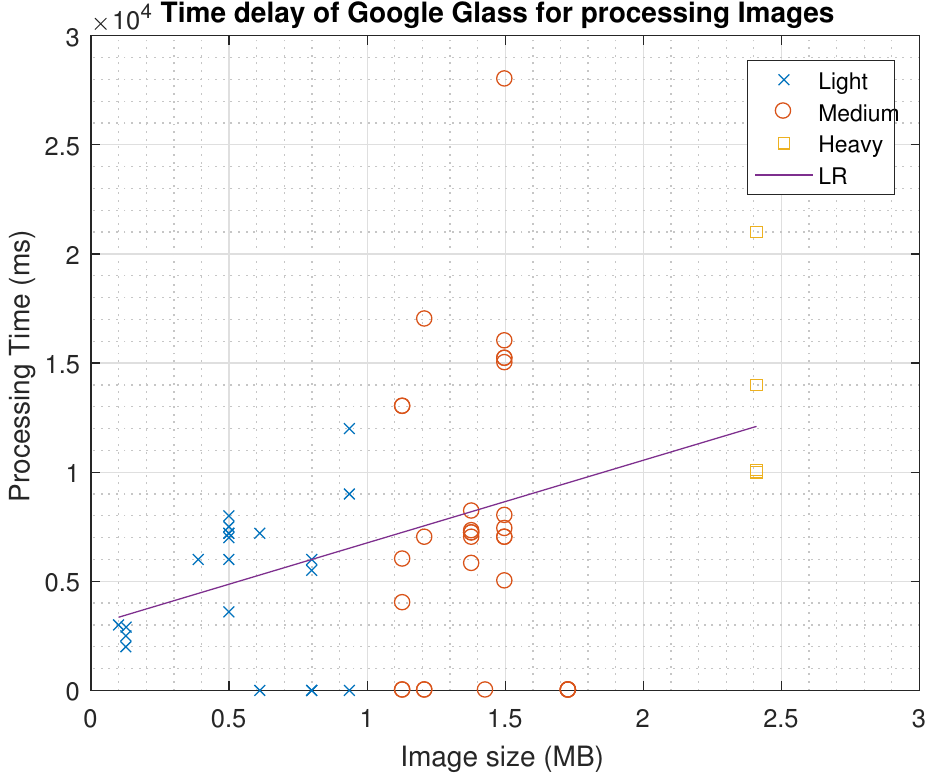
Figure 6. Relationship between image size and processing time of Google Glasses to show the image in the prism. Failed tests are marked with a 0 delay (overlapped with x axis). Linear regression (LR) goodness to fit has a R 2 =